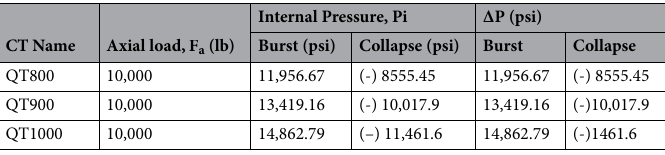
Table 4. P&T limit data for zero external pressure, P o .